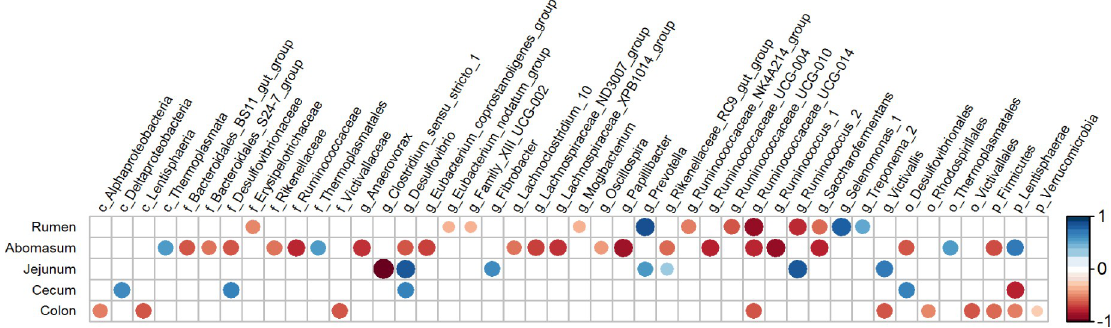
Fig 4. Correlation analysis between the bacteria across the gastrointestinal tract and the true digestibility of phosphorus in goats. Correlations are indicated by large circles and weaker correlations by small circles. The scale colors denote whether the correlation is positive (closer to 1, red circles) or negative (closer to − 1, blue circles) between the taxa and gastrointestinal tract variables.